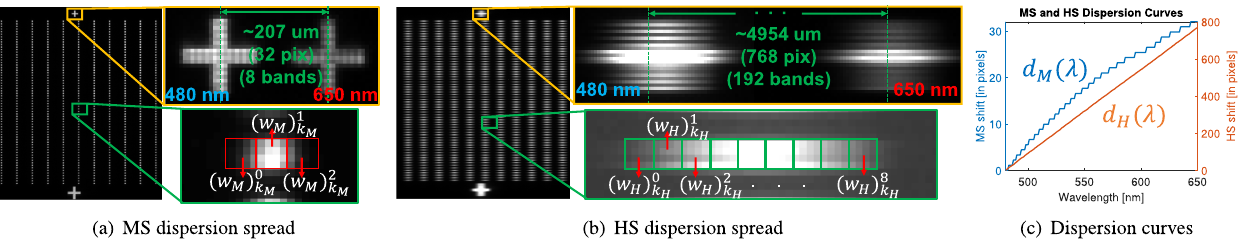
Figure 3. Characterization of dispersion functions. ( a ) Image obtained in the MS arm at 550 nm. ( b ) Image obtained in the HS arm at 550 nm. ( c ) Non-linear MS dispersion curve (left y-axis) and linear HS dispersion curve (right y-axis) in terms of wavelength. The prism spreads the 480–650 nm spectral range along 207 µ m (up to 32 MS sensor pixels), whereas the diffraction grating disperses it along 4954 µ m (up to 768 HS sensor pixels). , ( w M ) 1 , ( w M ) 2 Each DMD pixel affects three MS sensor pixels, with intensity weights ( w M ) 0 k k M k M (as detailed M in Table S1 in the supplementary material), while the same DMD pixel impinges in up to 9 HS sensor pixels k M , ( w H ) 1 , . . . , ( w H ) 8 with intensity weights ( w H ) 0 k k H k H (as detailed in Table S2 in the supplementary material). H indexes the MS bands and k H indexes the HS bands, as explained in the “Methods”